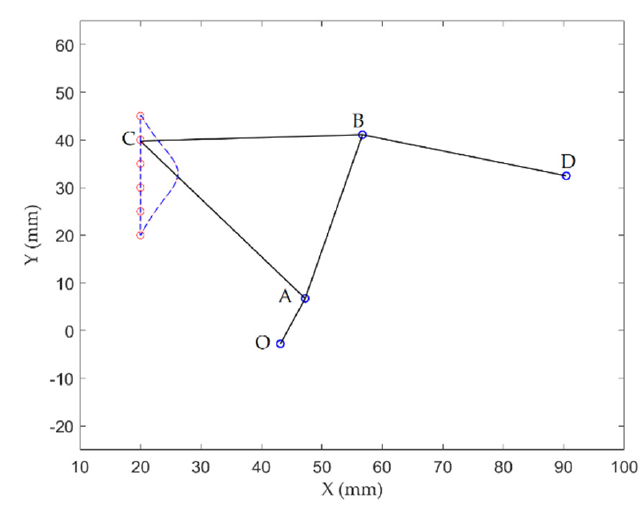
Figure 18. Trajectory of the coupler point of Case 4.